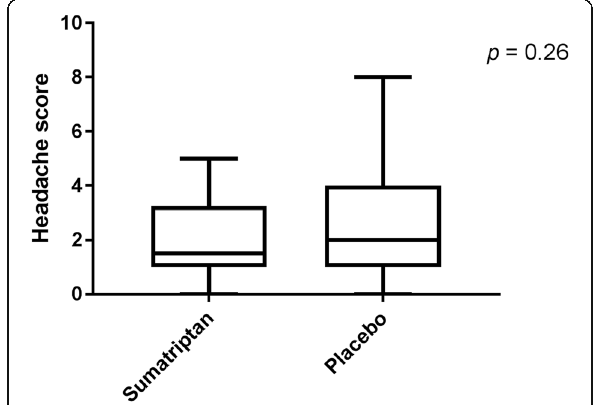
Fig. 3 Peak headache score. Difference in median peak headache score on the two treatment days was not statistical